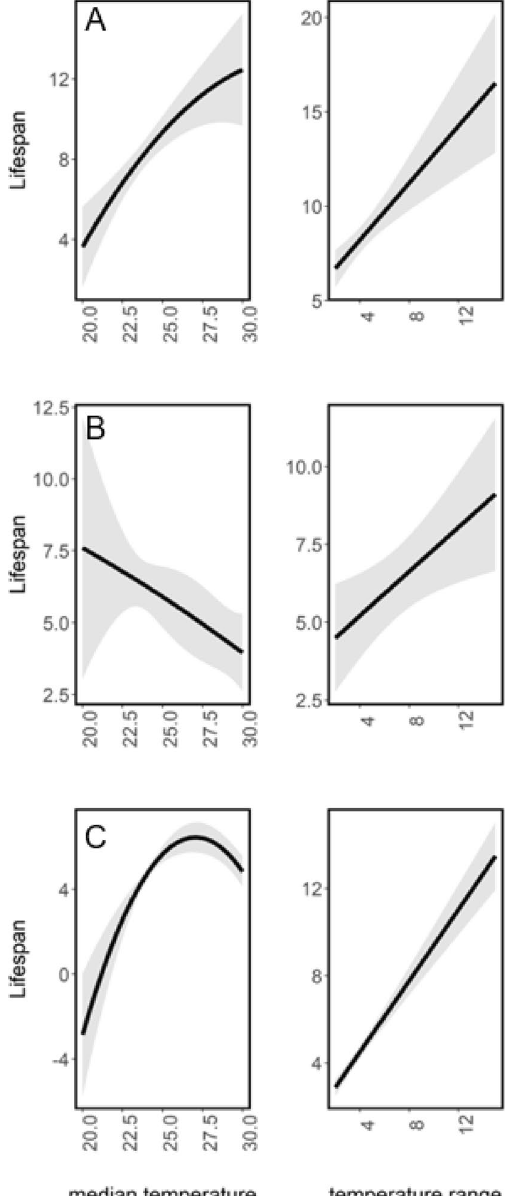
Figure 3. Associations of variation in thermal utilization with individual lifespan in three butterfly species. Thermal utilization is inferred from the median (left panels) and the range (max–min, right panels) of ambient temperatures, respectively, at the time of collection. Lifespan is inferred from retention time in the population. Data for ( A ) Marsh Fritillary ( Euphydryas aurinia ), ( B ) Apollo ( Parnassius apollo ) , and ( C ) Large Blue ( Phengaris arion ) butterfly individuals captured on at least three separate days. Effects plots based on results from the general linear models are shown (see Table